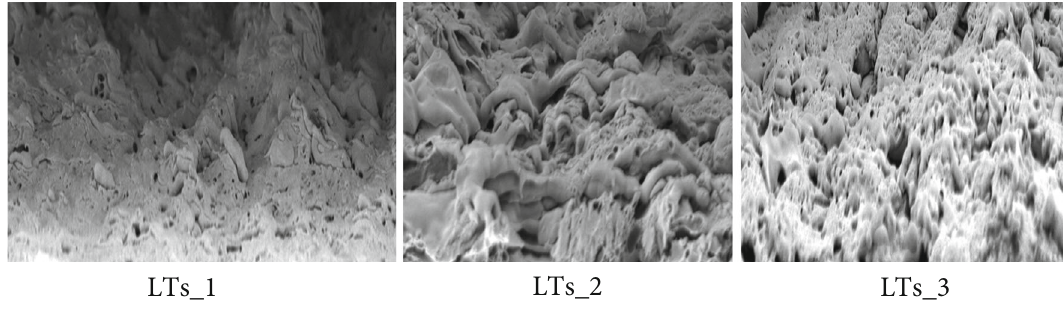
Figure 4: SEM images of laser-textured